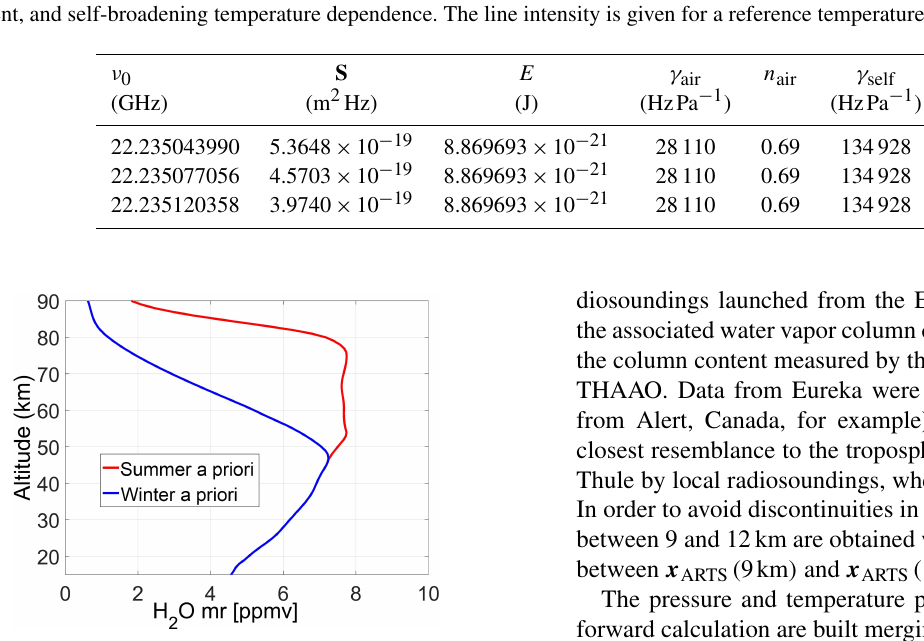
Figure 6. The a priori profiles employed by VESPA-22 for the October–April period (indicated as winter a priori, blue line) and for the June–August period (indicated as summer a priori, red line) obtained from